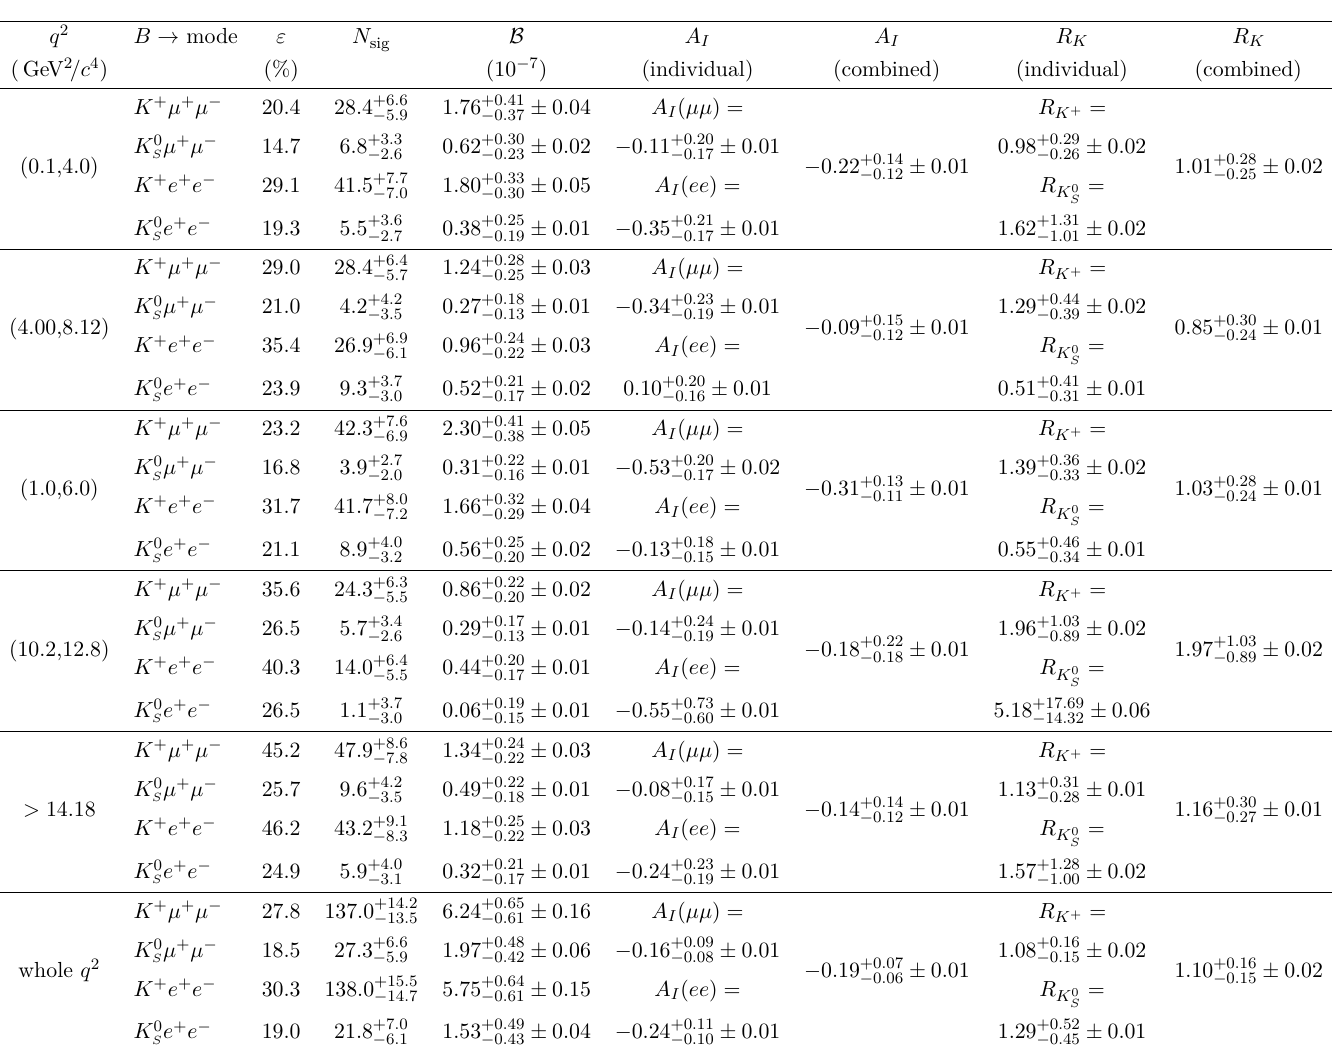
Table 1 . Results from the fits. The columns correspond to the q 2 bin size, decay mode, reconstruction efficiency, signal yield, branching fraction, lepton-flavor-separated and combined A I and R K